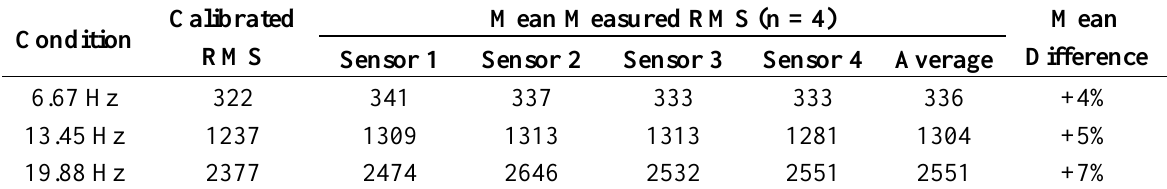
Table 1. Results from dynamic calibration of four sensors on a mechanical oscillator. Calibrated and measured RMS are the mean RMS and its standard